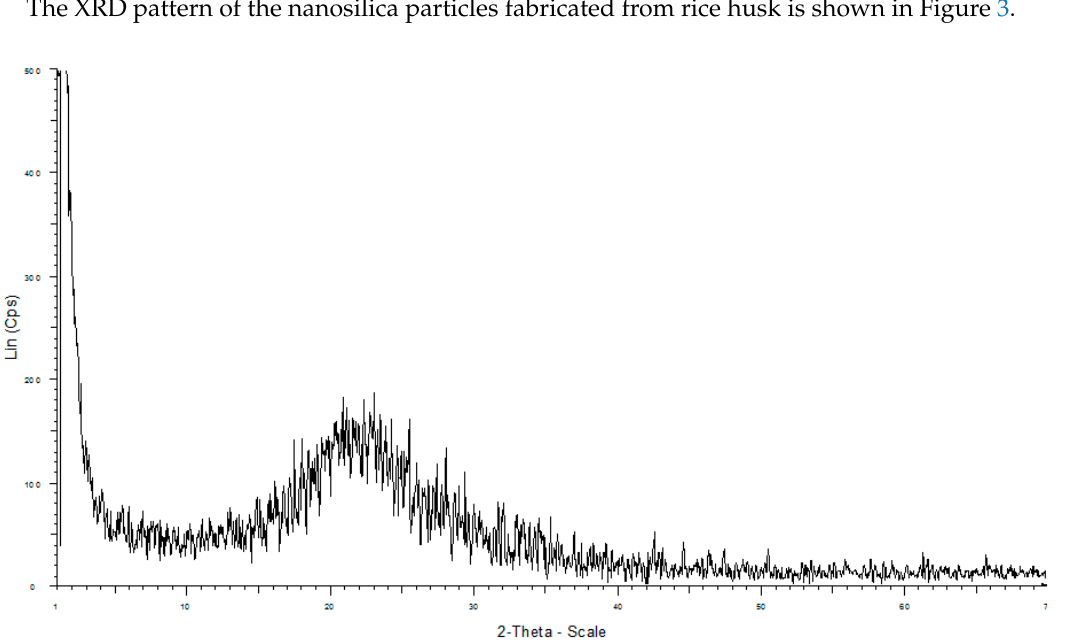
Figure 3 . XRD pattern of nanosilica synthesized from rice husk. Figure 3. XRD pattern of nanosilica synthesized from rice